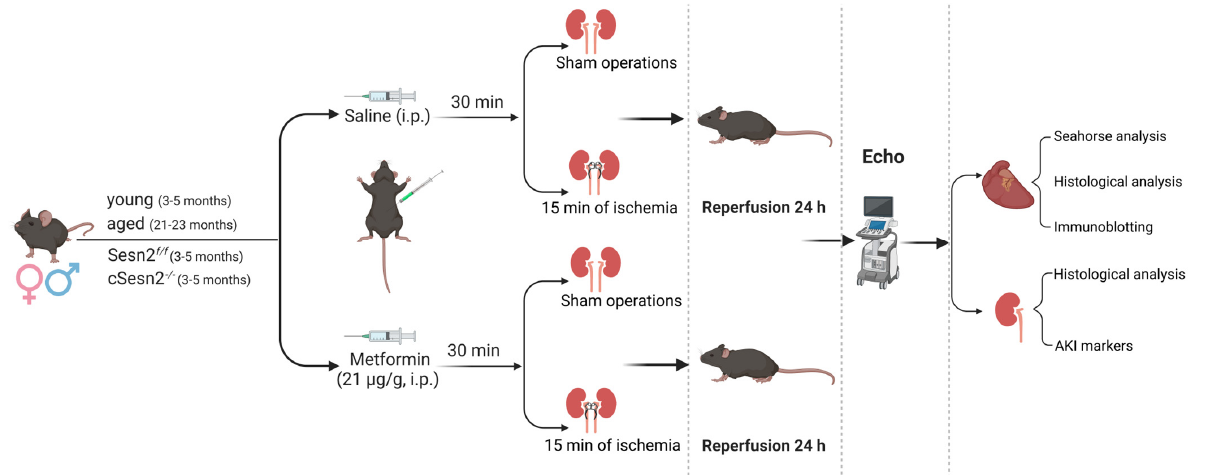
Figure 1. Experimental design. Male and female young and aged C57BL/6J wild ‐ type mice along with cSesn2 − / − and Sesn2 f/f C57BL/6J mice underwent a laparotomy and the clamping of the renal artery and vein for 15 min, followed by 24 h of reperfusion. Echocardiograms were performed, and tissues were collected for immunoblotting, histopathological, AKI induction, and mitochondrial respiration analyses.